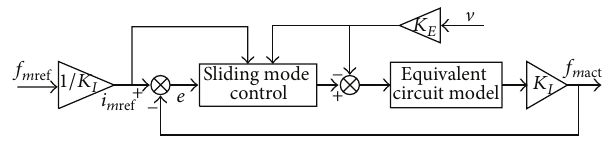
Figure 5: Control scheme of linear motor. Table 4: Relations between 𝑁 and the motor optimal power